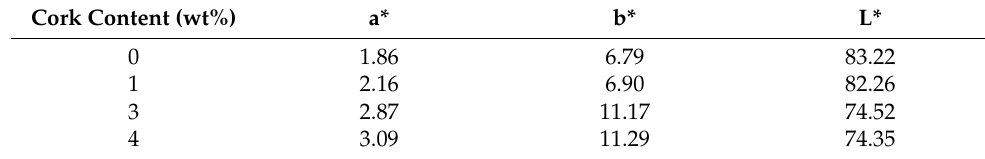
Figure 5. Color variation of mortar samples induced by the addition of cork waste: visual macroscopic evidence of mortars containing increasing cork content from left to right ( a ) and colorimetry values of representative samples containing 0 wt% and 4 wt% of cork ( b ). Table 3. Colorimetry test results for